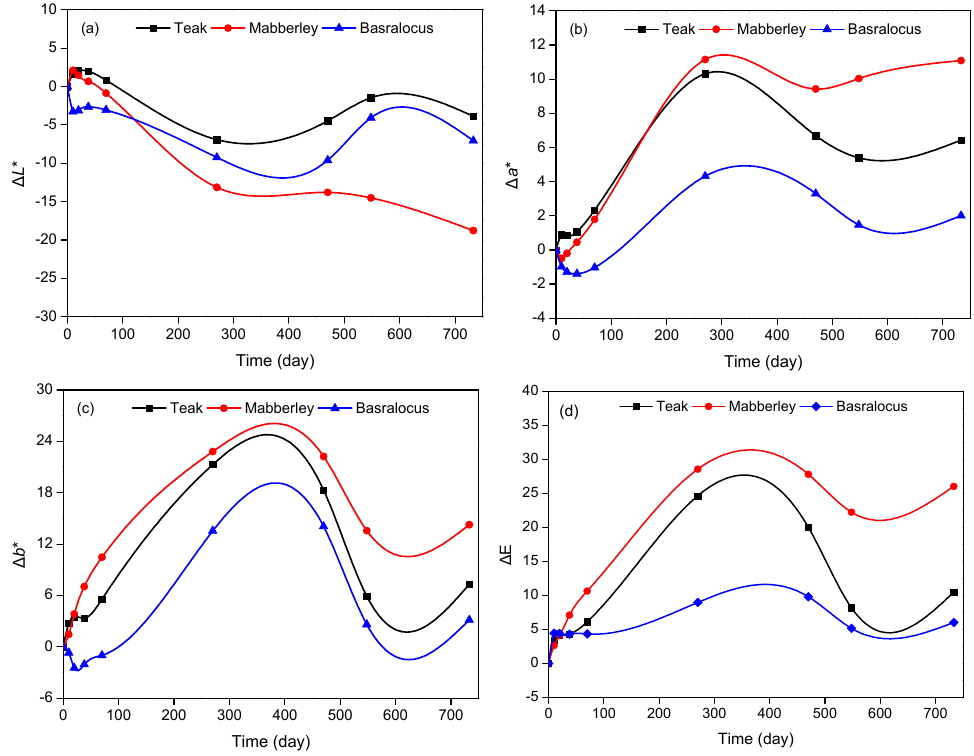
Figure 2. Color changes of woods during natural sunlight weathering. ( a ) ∆ L *; ( b ) ∆ a *; ( c ) ∆ b *; ( d ) ∆ E